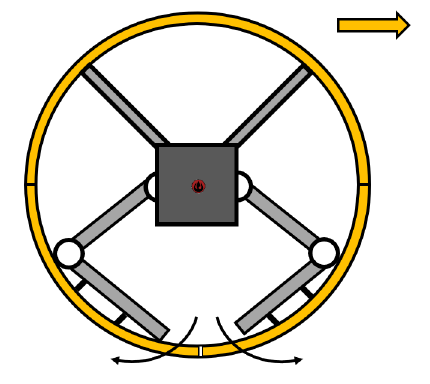
Figure 8. Principle sketch of a hybrid SR. Dynamics